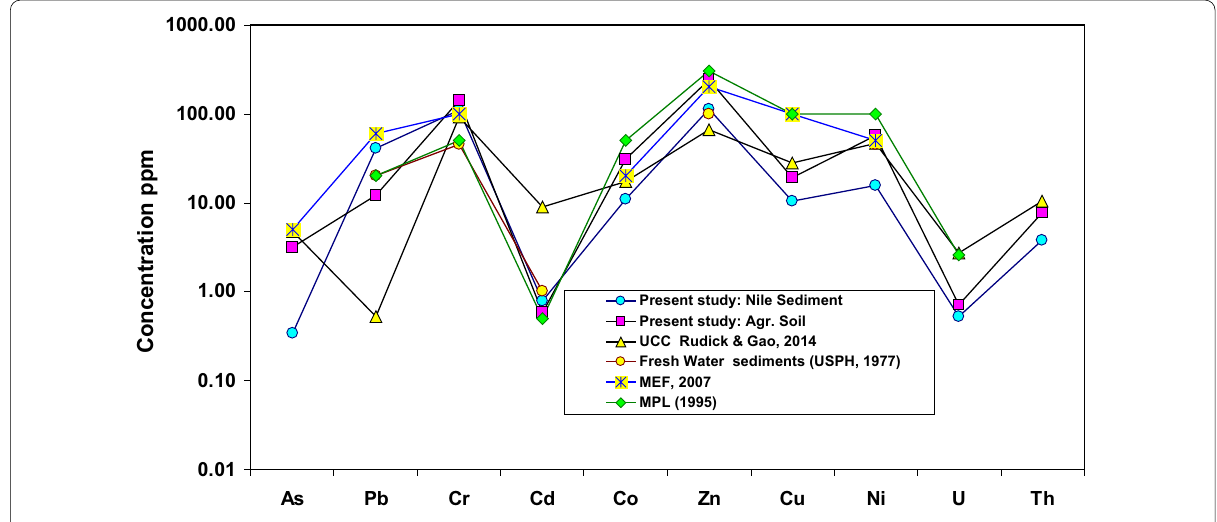
Fig. 3 Spider diagram showing comparison the elements (ppm) in the study samples with